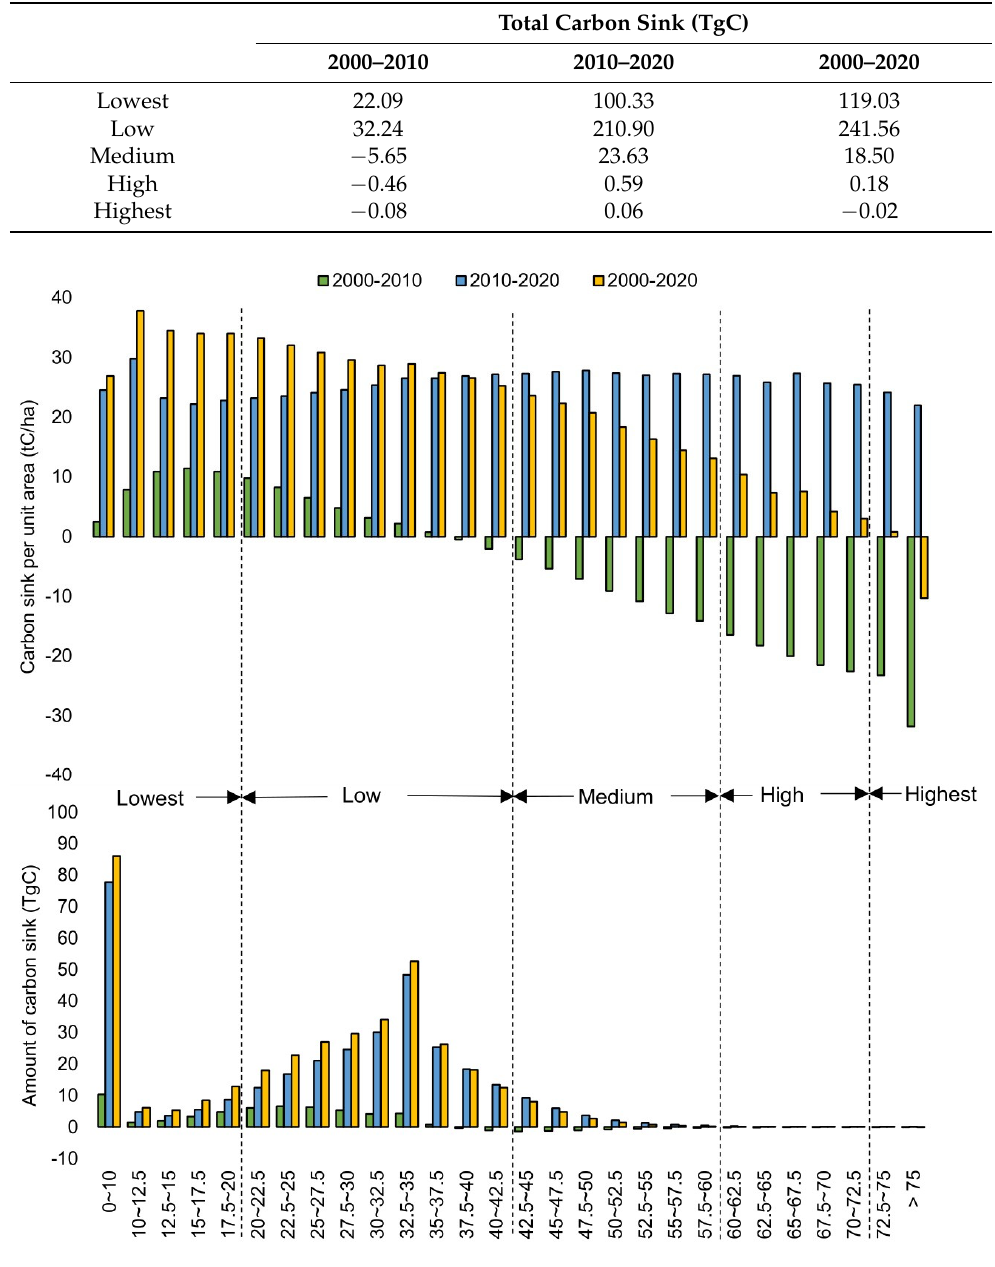
Table 5. Carbon sinks from 2000 to 2020 at different carbon density levels.